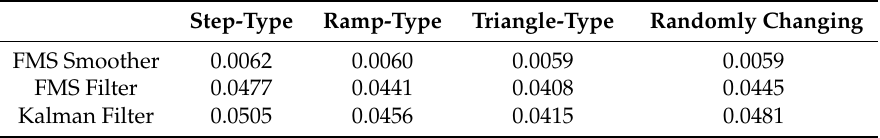
Table 2. Comparison of mean of RMS estimation errors.